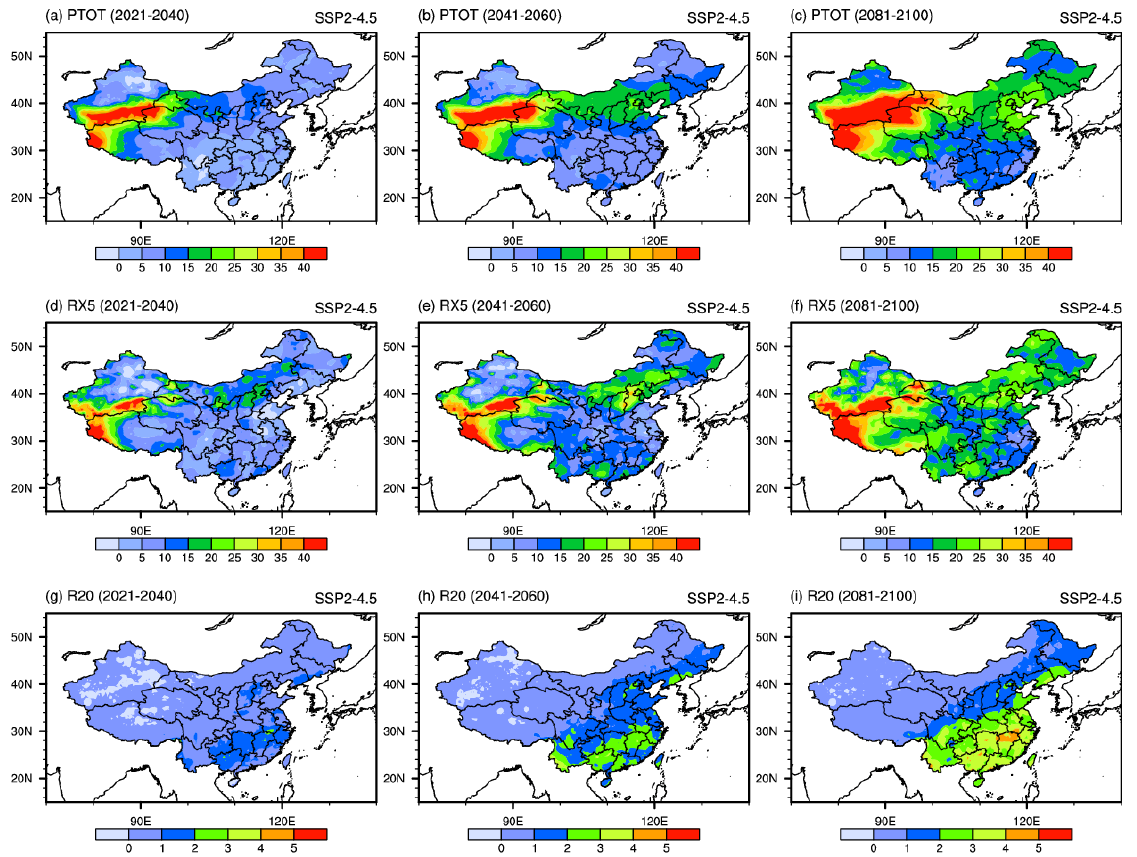
Figure 5. Spatial patterns of extreme precipitation indices (units: %) projected by the downscaled CMIP6 MME under SSP2-4.5 scenario in the 21st century.